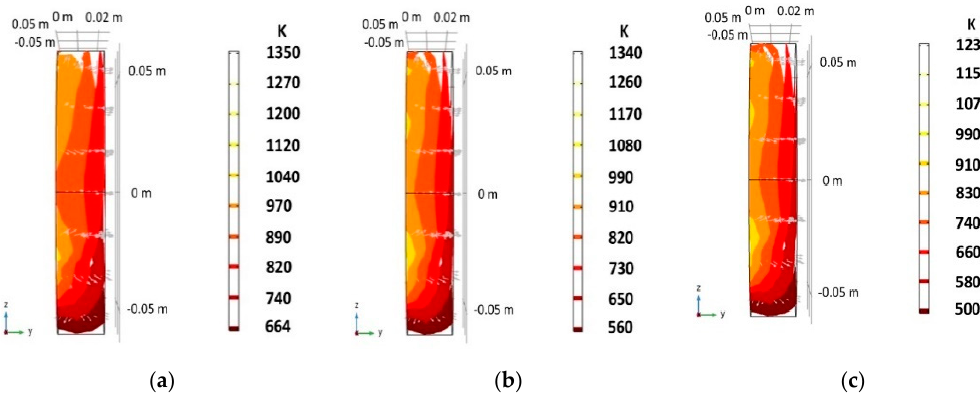
Figure 9. Isothermal surfaces on the z - y plane (perpendicular to thickness) of the absorber material. ( a ) 10 PPI, ( b ) 20 PPI, and ( c ) 30 PPI.